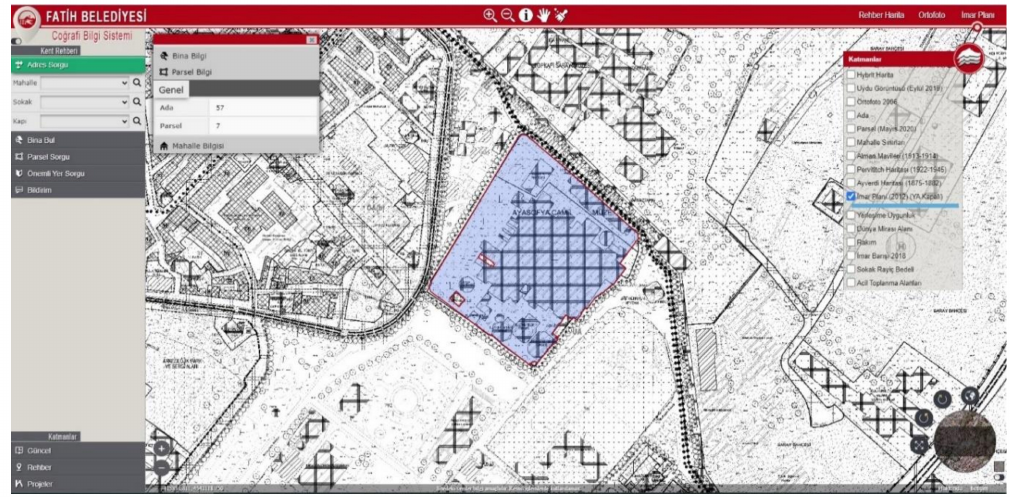
Figure 8. Conservation zoning plan of Hagia Sophia